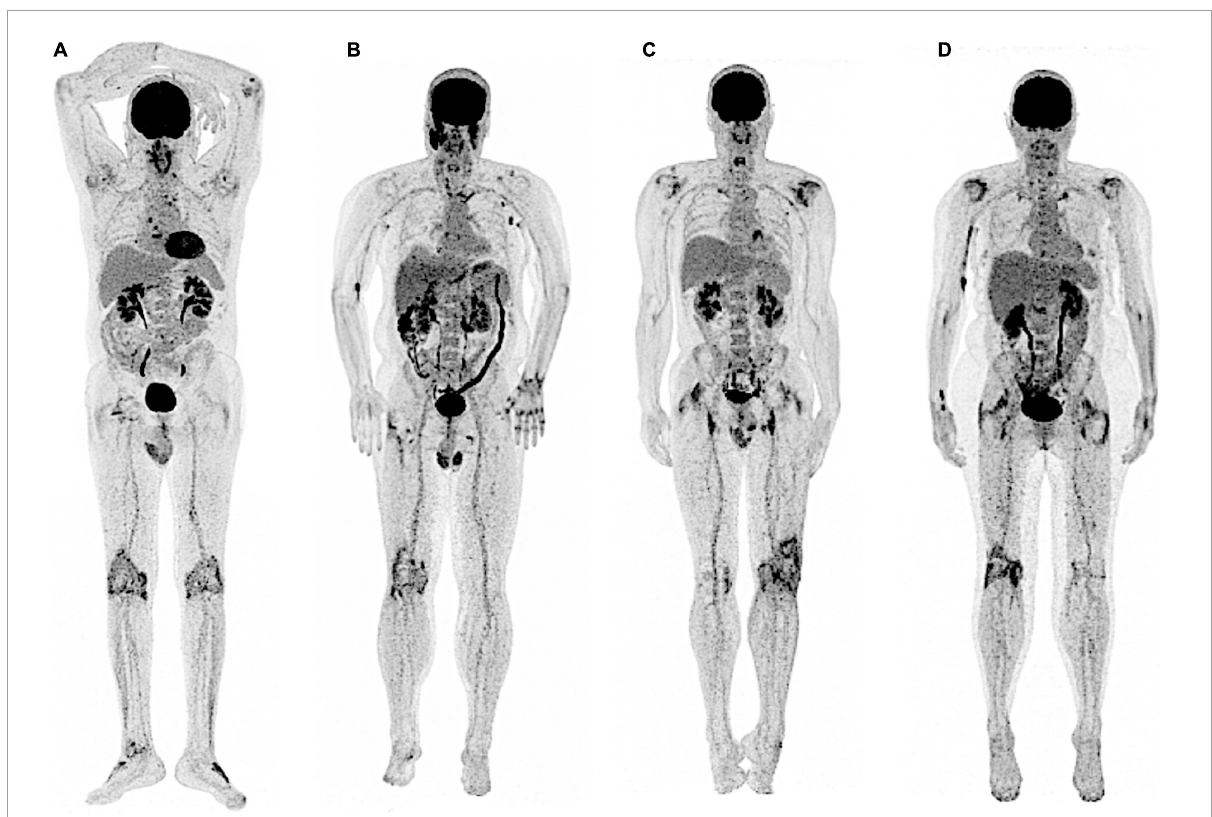
FIGURE1 SpA and PMR: typical but non-specific periarticular patterns of 18 F-FDG uptake at the individual whole-body level. In both SpA (A,B) and PMR (C,D) , typical increase of 18 F-FDG uptake is frequently observed in the scapular and pelvic girdles as illustrated here, but also at sterno-clavicular joints and interspinous processes. In both CIR, peripheric articular involvement (knees) may also be observed. Typical 18 F-FDG PET findings are thus non-specific at the patient